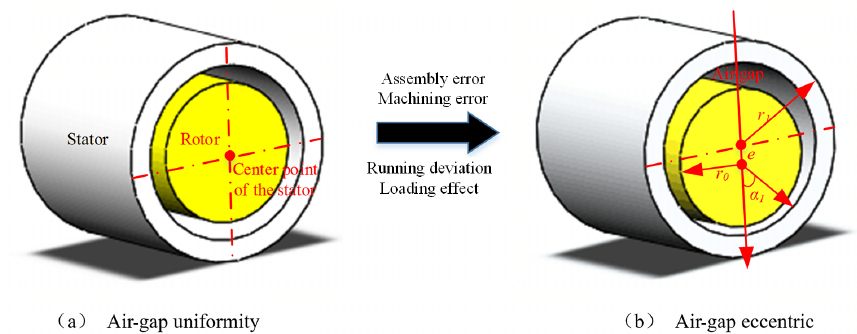
Figure 1. Air-gap eccentric state of the